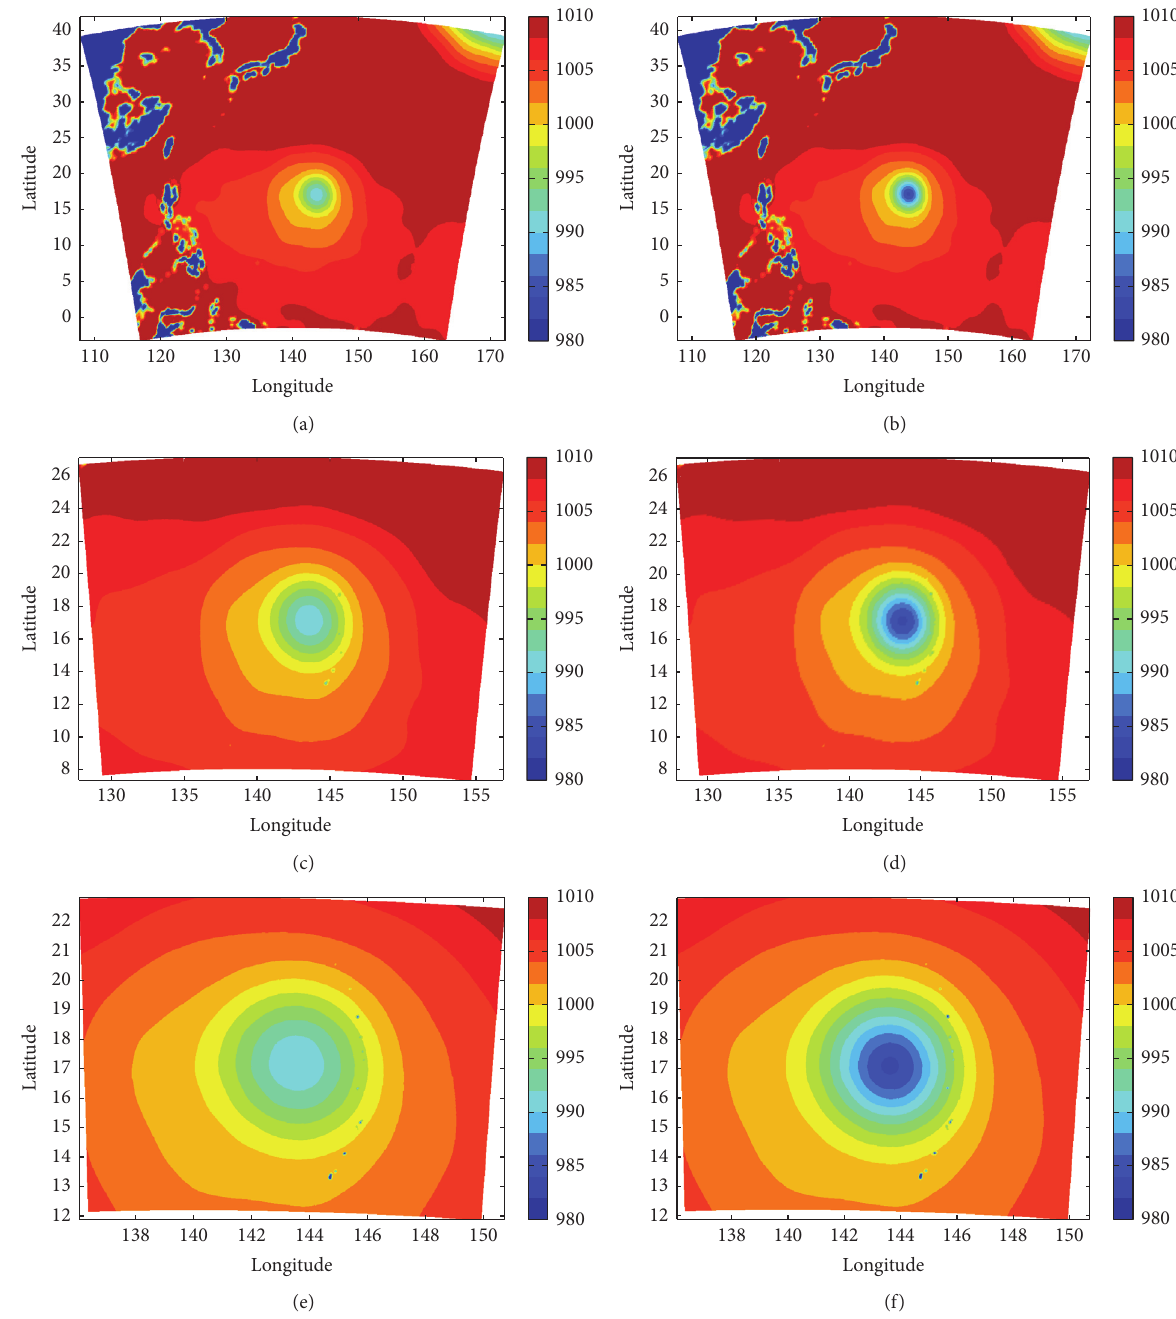
Figure 2: Phanfone: (a) 𝑝 𝑠 before initialization in D01 (27km); (b) 𝑝 𝑠 after initialization in D01 (27 km); (c) 𝑝 𝑠 before initialization in D02 (9km); (d) 𝑝 𝑠 after initialization in D02 (9km); (e) 𝑝 𝑠 before initialization in D03 (3km); and (f) 𝑝 𝑠 after initialization in D03 (3 km). The unit in these figures is